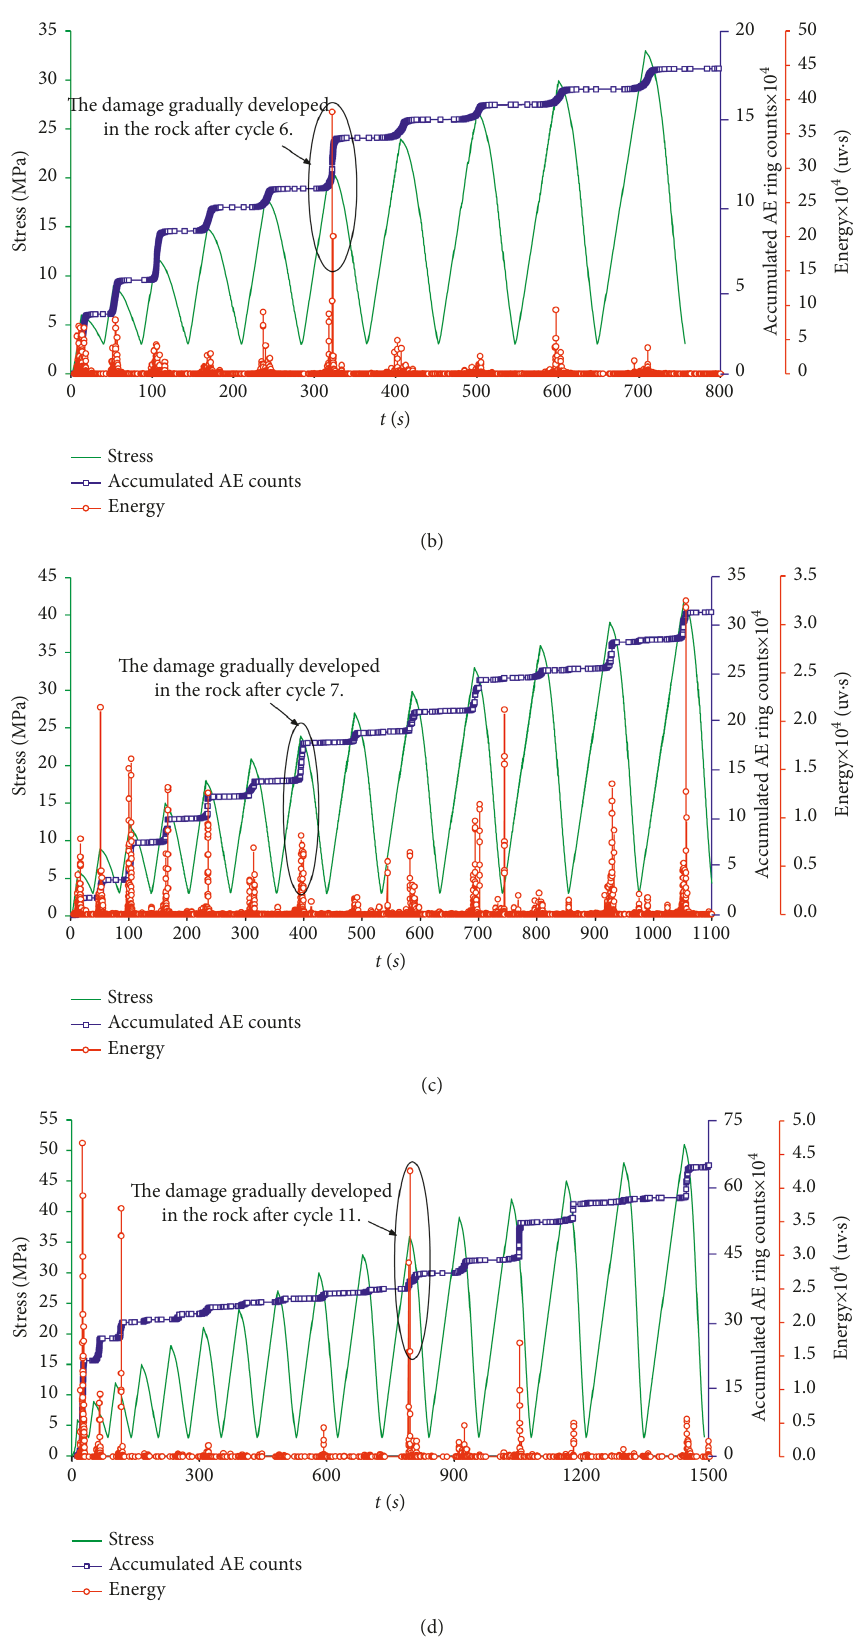
Figure 3: AE data of PD rock sample. (a) S-1 rock sample. (b) S-2 rock sample. (c) S-3 rock sample. (d) S-4 rock